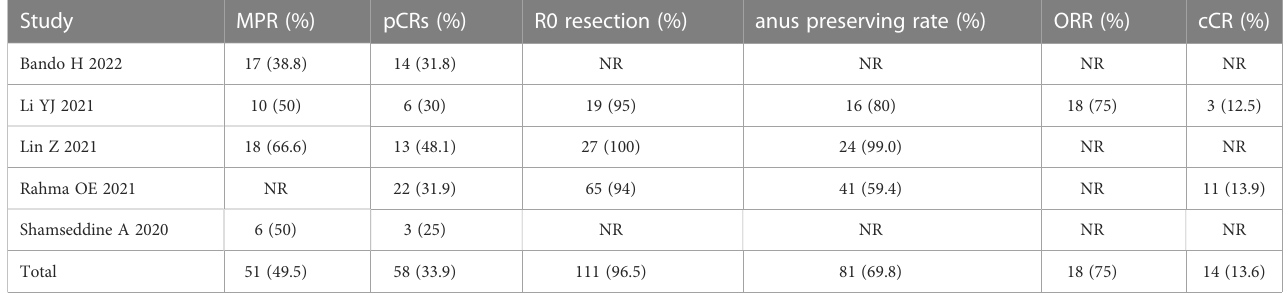
TABLE 4 outcomes for rectal cancer.